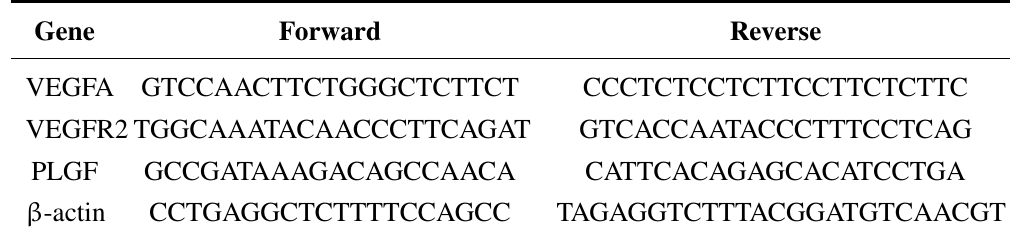
Table 1. Sequences of forward and reverse primers used in real-time RT-PCR (5 1 Ñ 3 1 ). Gene Forward Reverse VEGFA GTCCAACTTCTGGGCTCTTCT VEGFR2 TGGCAAATACAACCCTTCAGAT PLGF β -actin TAGAGGTCTTTACGGATGTCAACGT VEGFA, vascular endothelial growth factor A; VEGFR2, vascular endothelial growth factor receptor 2; PLGF, placental growth factor.